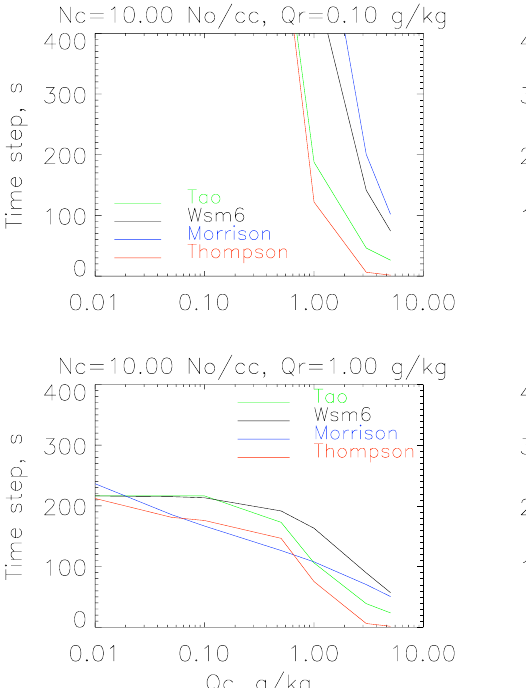
Fig. 1. Maximal time step dependence on Q c and Q r for N c = 10 cm − 3 .